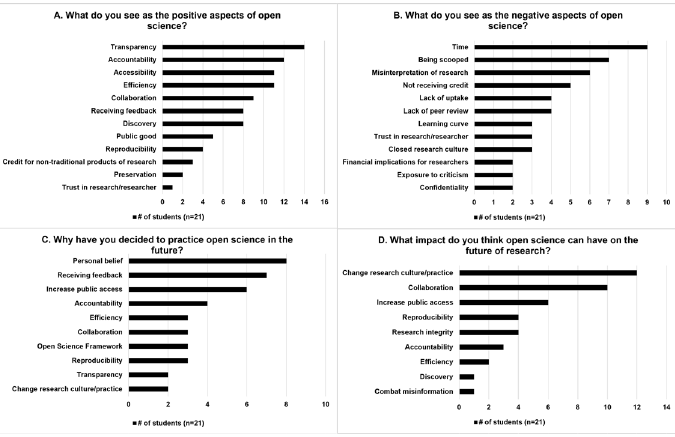
Figure 2A-D Themed responses on student experiences practicing open